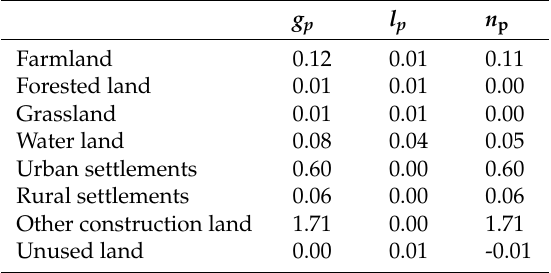
Table 2. Gain-to-persistence, loss-to-persistence, and net change-to-persistence ratios of the land types. g p l p n p Farmland